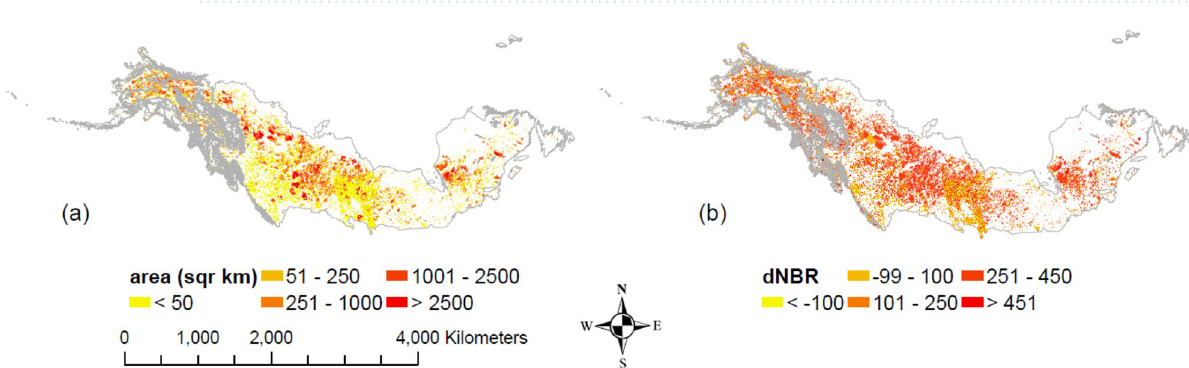
Figure 2. Fire area and burn severity (as dNBR) during 1986–2016 in NA boreal forest. ( a ) Fire area in km 2 . ( b ) Burn severity measured by the mean dNBR value within its perimeter. For both panels, the grey lines show the boundary of boreal forest. This figure was created by ArcMAP 10.7.1, (https:// www. esri. com/ en- us/ arcgis/ produ cts/ arcgis- maps- for- office/ downl